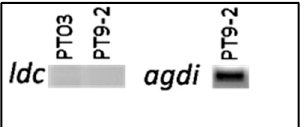
Figure 4. PCR related to biogenic amines (BAs) production. PCR products of the lysine decarboxylase (ldc) and agmatine deiminase (agdi) genes.